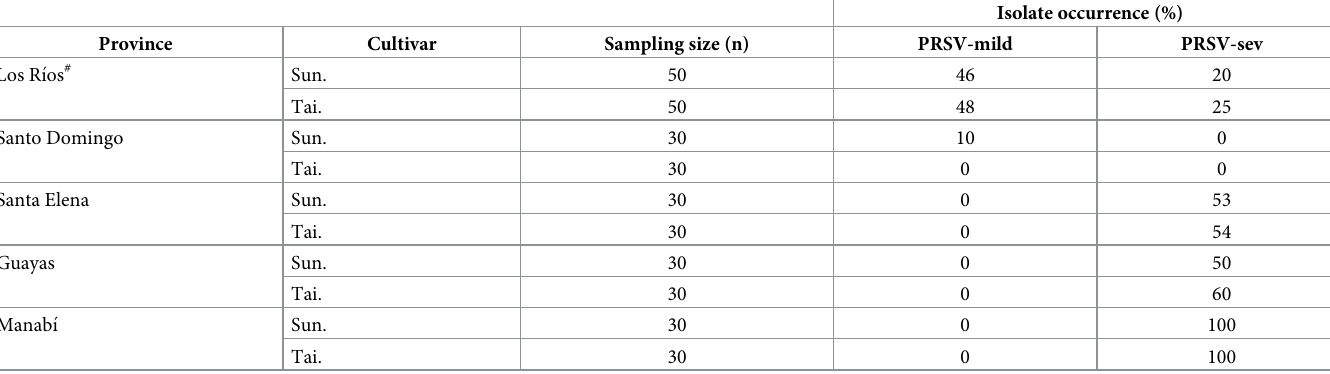
Table 1. Field occurrence of the mild and severe isolates of papaya ringspot virus (PRSV-mild and